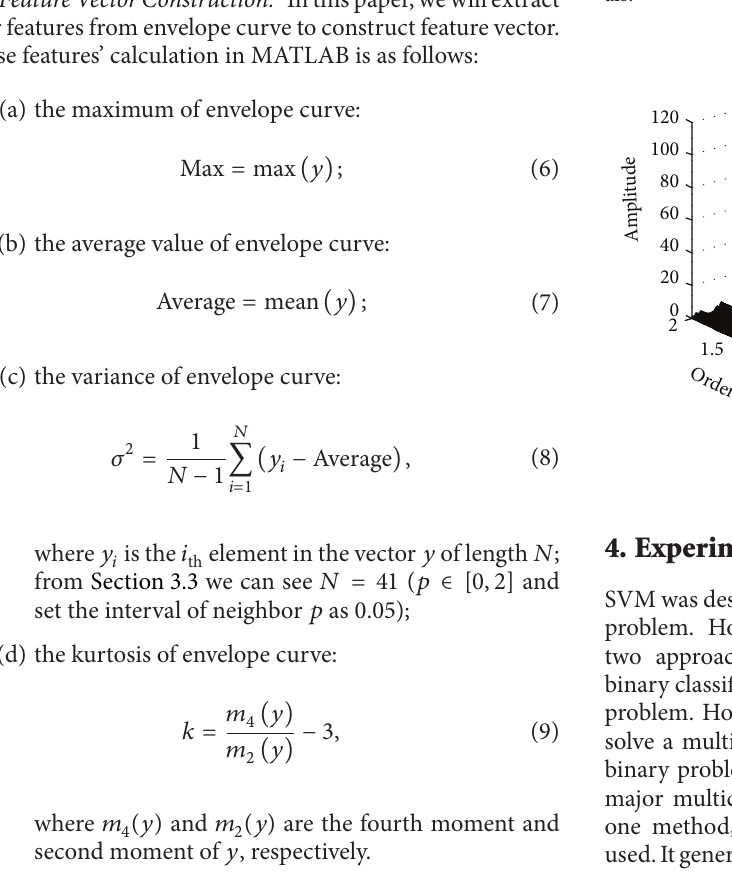
Figure 7: The fractional domain-envelope curve of the four materi- als.